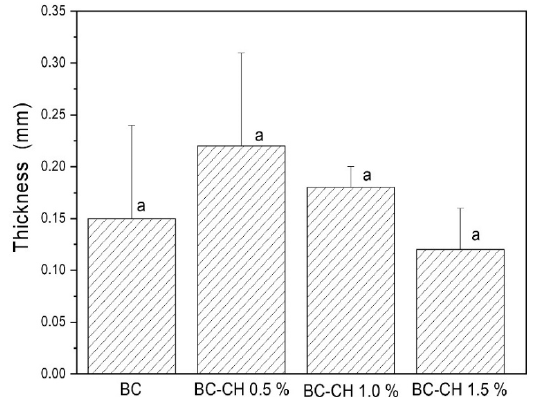
Figure 4. Thickness of BC and BC-CH films coated with various concentrations of chitosan. Average ± standard deviation. Letter (a) indicates no significant differences ( p > 0.05) between treatments.